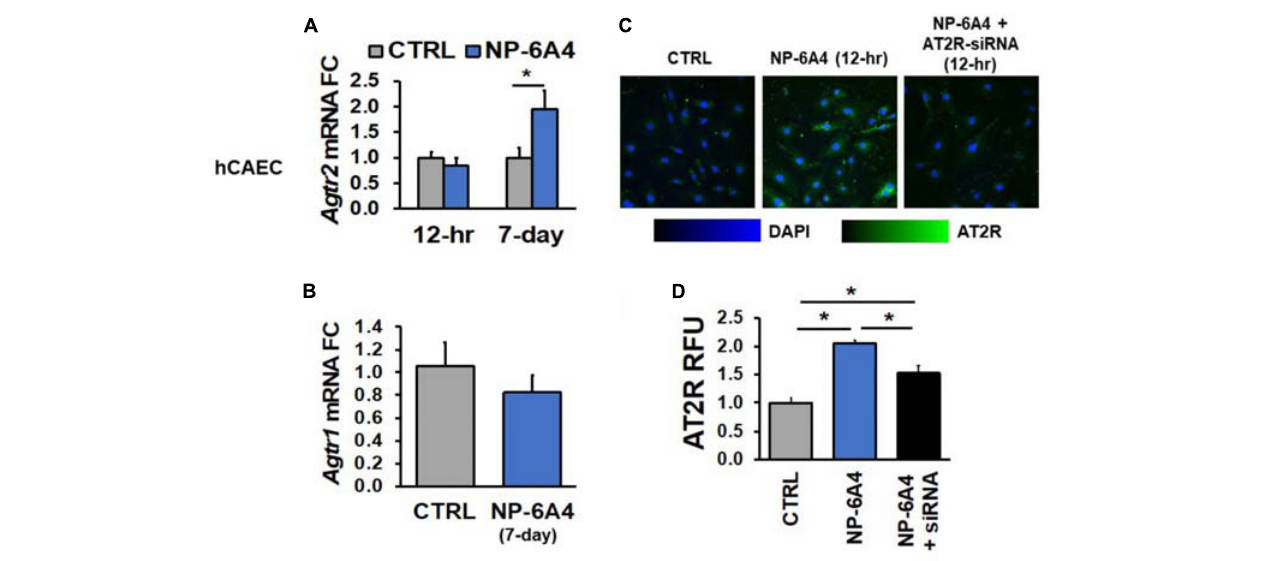
FIGURE 2 | NP-6A4 increased Agtr2 mRNA and AT2R protein expression in hCAECs. (A) 1 µ M NP-6A4 for 12-h showed no difference in Agtr2 mRNA, while 7-day treatment increased Agtr2 mRNA expression twofold. (B) No change in Atgr1 was detected after 1 µ M NP-6A4 for 7-days. n = at least three biological replicates and PCR replicates, respectively, for these experiment. (C) Representative images of hCAECs treated with 1 µ M NP-6A4 for 12-h. Blue indicates DAPI stained nuclei and green AT2R. Merged images are shown for all experimental conditions. (D) Quantification of relative fluorescent units (RFU) shows increased expression of AT2R protein after 1 µ M NP-6A4 treatment for 12-h. AT2R-siRNA prevented NP-6A4-induced increase in AT2R expression. Immunofluorescent experiments consisted of quantification of > 50 cells from triplicates per experiment. ∗ Indicates p < 0.05 using One-way ANOVA. hCAEC, human coronary artery endothelial cell; FC, fold change.